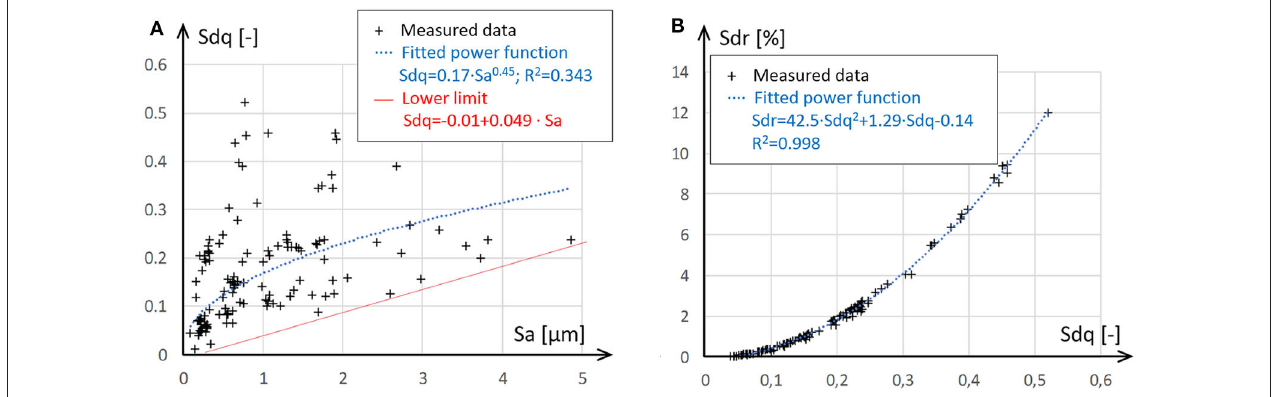
FIGURE 1 | Topological maps for the 117 topographies examined; (A) Sdq-Sa map; (B) Sdq-Sdr (hybrid)